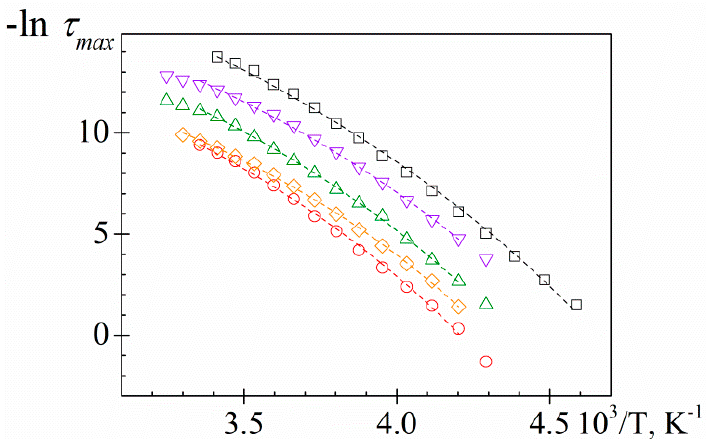
Figure 4. Temperature dependence of the relaxation times for analyzed samples. KC (circle), KCg (square) and KCg / x CHW nanocomposites with x = 5 (up triangle), 10 (down triangle) and 15 (diamond). Lines are the best fitting to the experimental data.